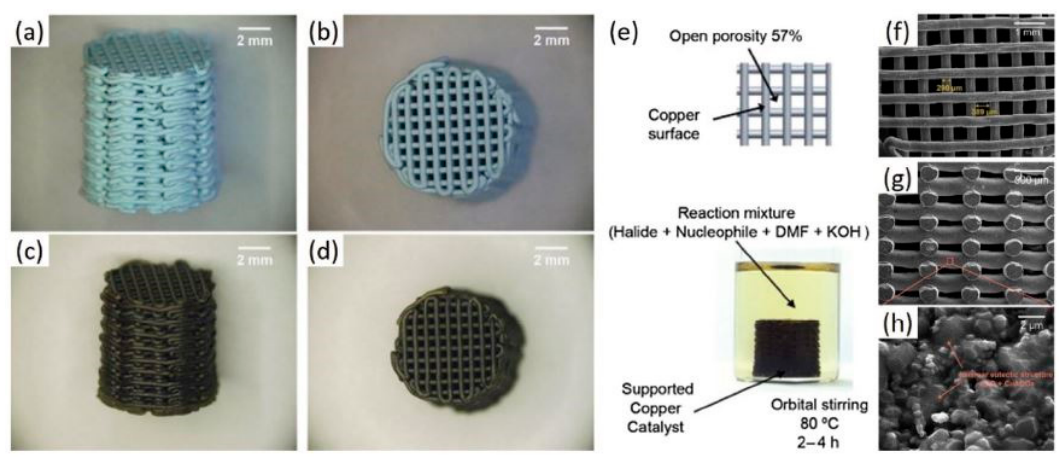
Figure 18. 3D printed Cu / Al 2 O 3 catalyst. ( a , b ) Optical images of the Cu / Al 2 O 3 structure without sintering. ( c , d ) Optical images of the sintered Cu / Al 2 O 3 . ( e ) Schematic illustration and image of the experimental setup used for the catalytic tests. ( f – h ) SEM images of sintered woodpile structure fabricated from a concentrated Cu / Al 2 O 3 ink deposited through a 410 µ m nozzle. Reproduced with permission [114]. Reproduced with permission from [114]. Copyright Elsevier,